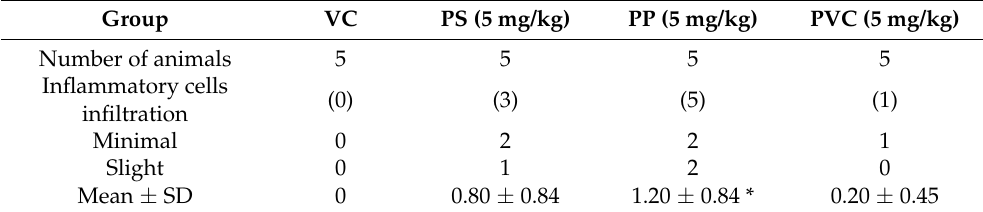
Table 3. Histopathological findings in the lung of ICR mice following microplastic intratracheal instillation.